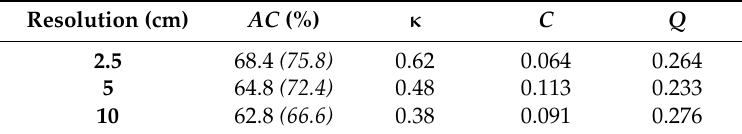
Table 4. Summary of overall hydromorphological feature identification performance per resolution.